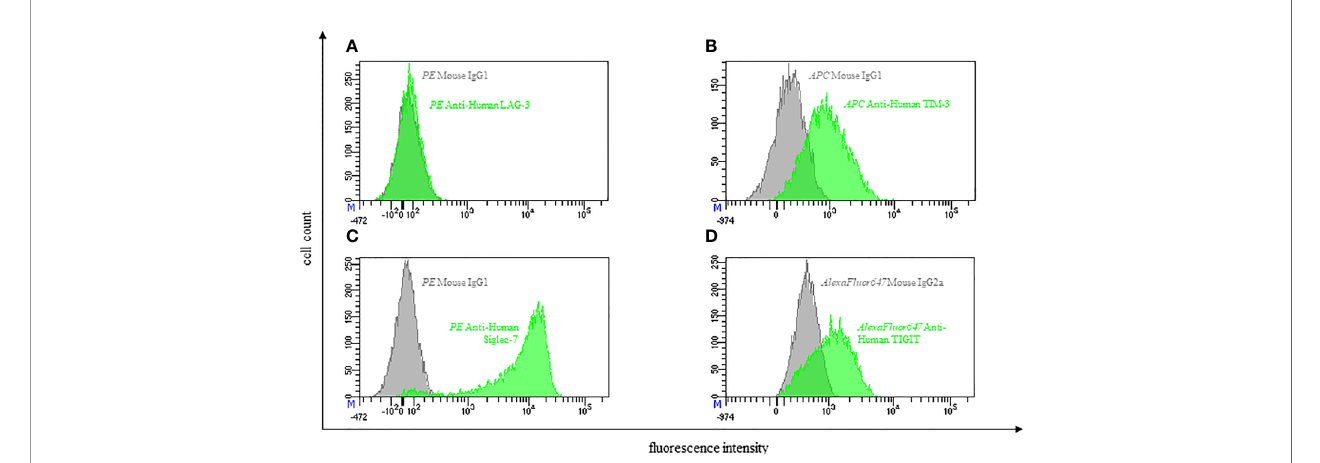
FIGURE 2 | Representative fl ow cytometric analysis of the expression of immune checkpoints (green): LAG-3 (A) , TIM-3 (B) , Siglec-7 (C) and TIGIT (D) on resting NK cells of a healthy donor (male, 23 years old) compared with isotype control